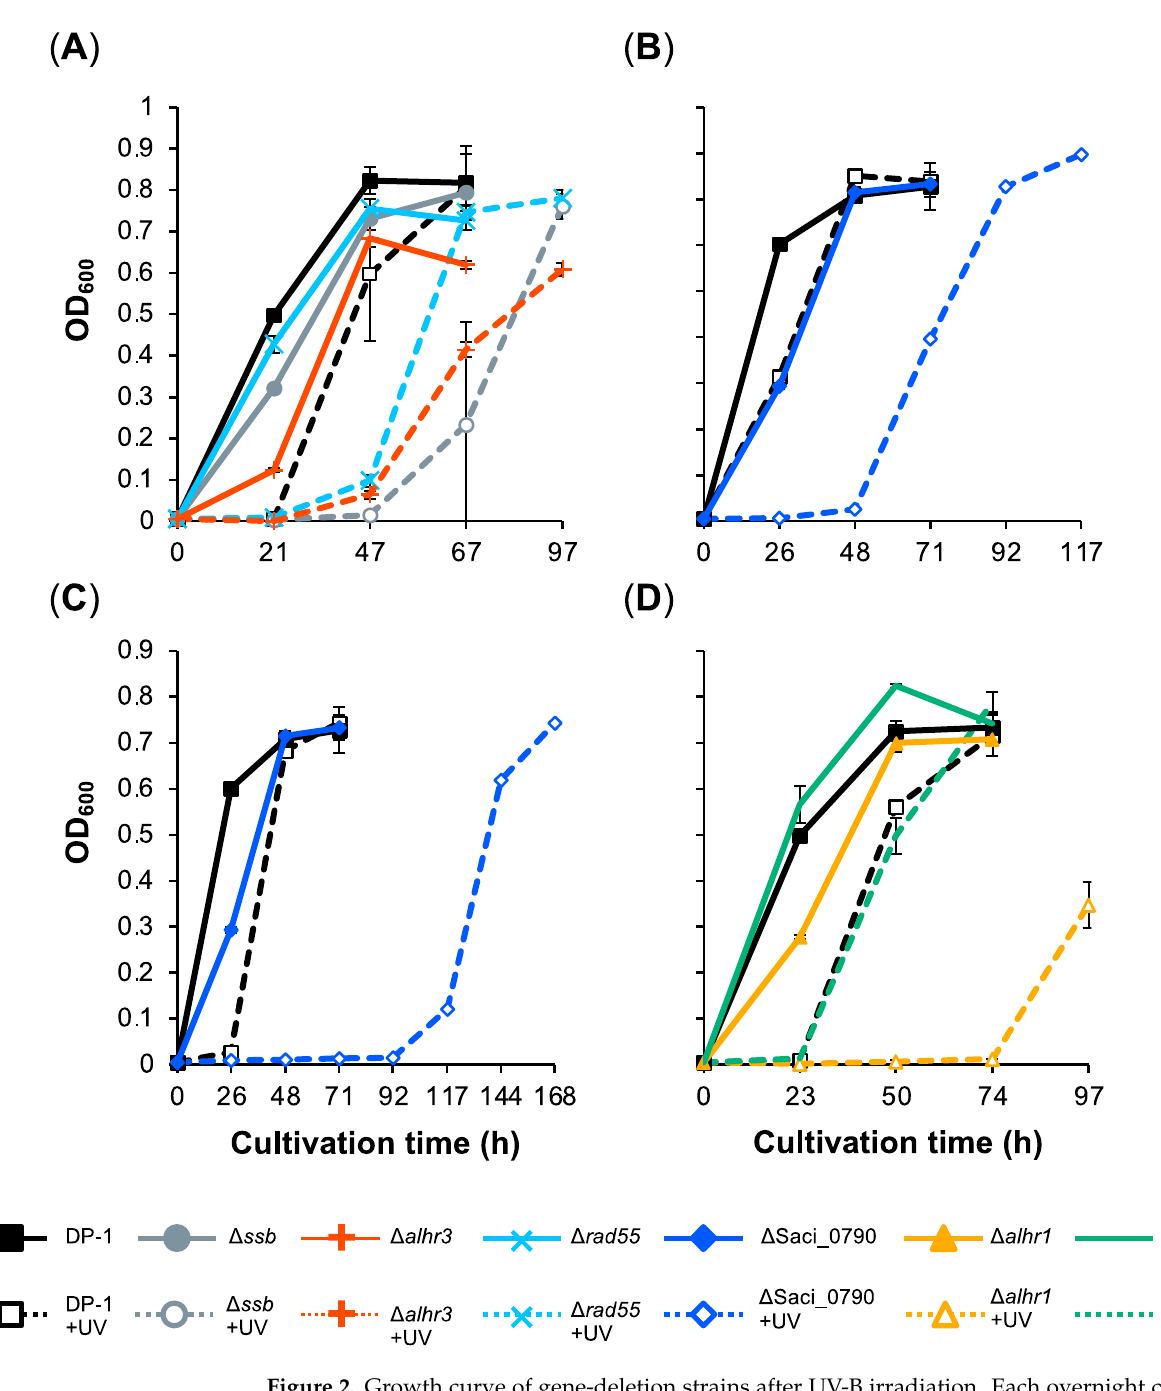
Figure 2. Growth curve of gene-deletion strains after UV-B irradiation. Each overnight culture of DP-1 (parent strain), Δ ssb , Δ alhr1, Δ alhr3 , Δ sftH , Δ rad55 , and Δ Saci_0790 was irradiated with UV-B light (800 ( B ) and 1200 J/m 2 ( A , C , D ); +UV represents a UV-treated sample) followed by inoculation in a liquid medium and cultivation at 75 °C with shaking. Growth curves for Δ ssb , Δ alhr3 , and Δ rad55 are indicated in ( A ), those of Δ Saci_0790 are shown in ( B , C ), and those of Δ alhr1 and Δ sftH are displayed in ( D ). Error bars represent ±SD calculated using three biological replicates.